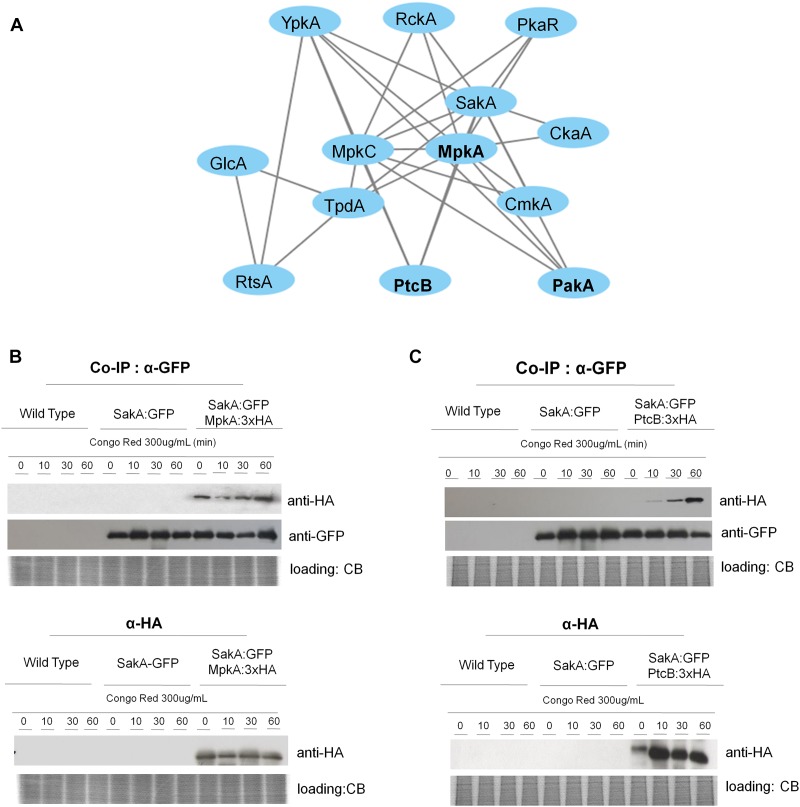
SakA:GFP associates with MpkA and PtcB. (A) Interaction network performed by using STRING (https://string-db.org/) showing the interaction among SakA, MpkC, MpkA, PtcB, and PakA. (B) Co-IP of SakA:GFP, MpkA:3xHA, SakA:GFP, and PtcB:3xHA. Affinity purification assays from GFP-tagged SakA strain in the background of 3xHA-tagged MpkA or PtcB were performed with GFP-Trap and anti-HA beads to verify interactions upon cell wall stress. CB, coomassie blue staining.